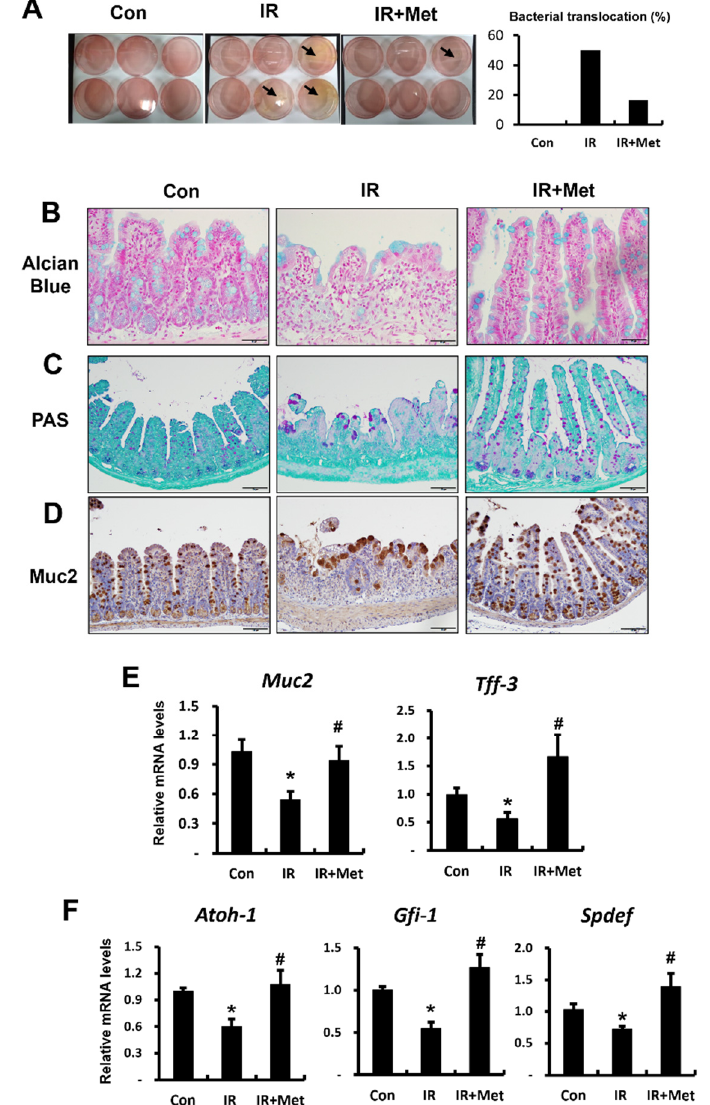
Figure 2. Metformin protected intestinal barrier function by indirectly regulating goblet cell maturation in radiation damage. ( A ) The percentage of bacterial translocation on mesenteric lymph nodes; ( B ) Alcian blue stain and ( C ) periodic acid–Schiff (PAS) stain for acidic and neutral mucin statin in the goblet cells; ( D ) immunohistochemistry of Mucin2 (Muc2) in the small intestine of control (Con), irradiated (IR), and metformin-treated IR (IR + Met) mice; ( E ) mRNA levels of Muc2, trefoil factor 3 (Tff3) of the intestinal tissue; ( F ) mRNA levels of atonal BHLH transcription factor 1 (Atoh-1), growth factor independent 1 transcriptional repressor (Gfi-1), and SAM pointed domain containing ETS transcription factor (Spdef) in the ileum of Con, IR, and IR + Met mice. Bar = 20 μ m. Data are presented as the mean ± standard error of the mean; n = 6 mice per group. * p < 0.05 compared to the Con group; # p < 0.05 compared to the IR group.